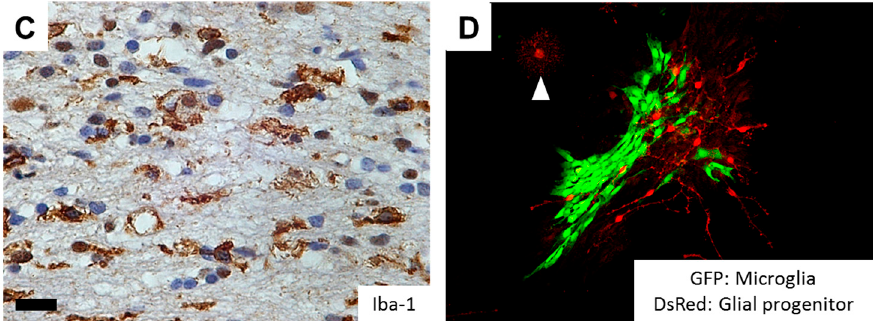
Figure 2. RTK signaling as a key determinant of glioma cell invasion. ( A ) In PDGF (platelet-derived growth factor)-induced rat glioma models, tumor cells demonstrate highly invasive features, so-called “Scherer’s secondary structures.” Scale bar = 50 µm; ( B ) Co-culture of PDGF-induced tumor cells (red) and NG2-positive glial progenitors (green) transforms glial progenitors into migratory morphology in a paracrine fashion; ( C ) In PDGF-induced rat glioma models, significant number of Iba-1-positive microglia are observed in the invasive front of the tumor. Scale bar = 15 µm; ( D ) Co-culture of microglial cell lines (green) and NG2-positive glial progenitors (red) from the rat brain transforms glial progenitors into migratory morphology, suggesting pro-invasive role of microglia. Note that the mature glial progenitor cells display oligodendroglial morphology with multipolar branches (arrowhead). GFP, green fluorescent protein; DsRed, Discosoma species red fluorescent protein; PDGF, platelet-derived growth factor; Iba-1, ionized calcium binding adapter molecule 1.